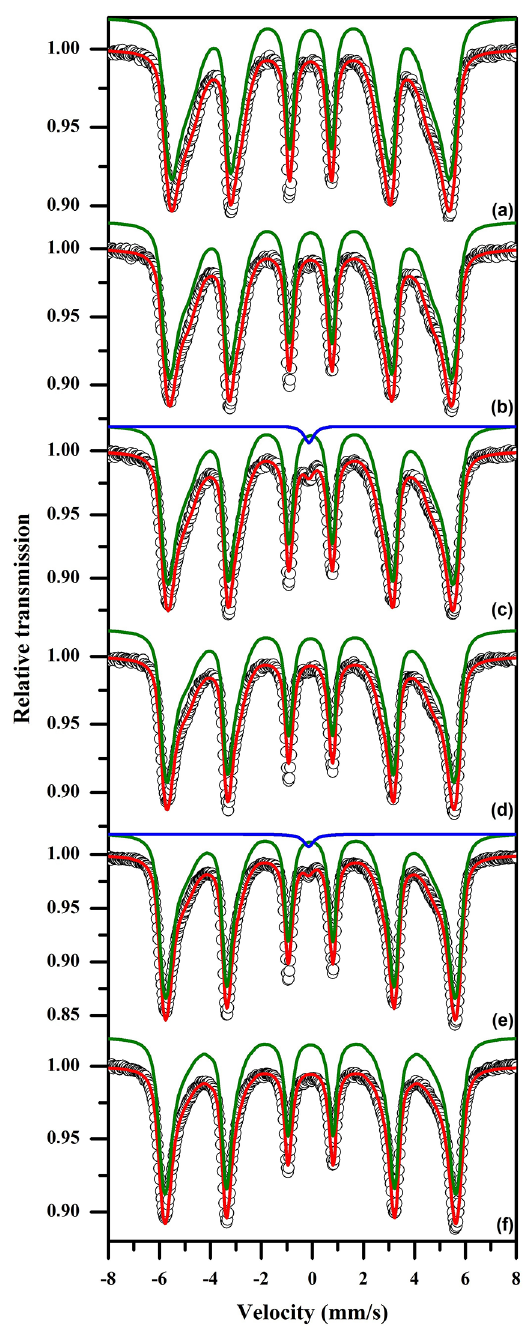
Figure 3. Mӧssbauer spectra of Maraging-300 steel solution-treated at 820°C for 30 min and aged at 440°C for various times: (a) as solution-treated; (b) 1 h; (c) 3 h; (d) 10 h; (e) 50 h; (f) 100 h.